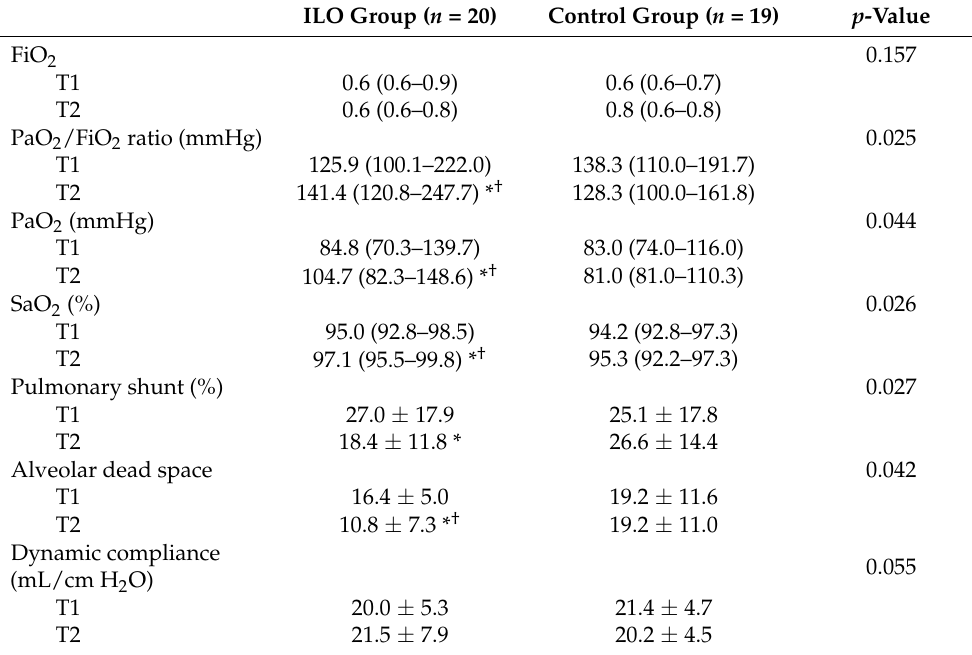
Table 3. Effects of iloprost on hemodynamics, oxygenation, and lung mechanics.